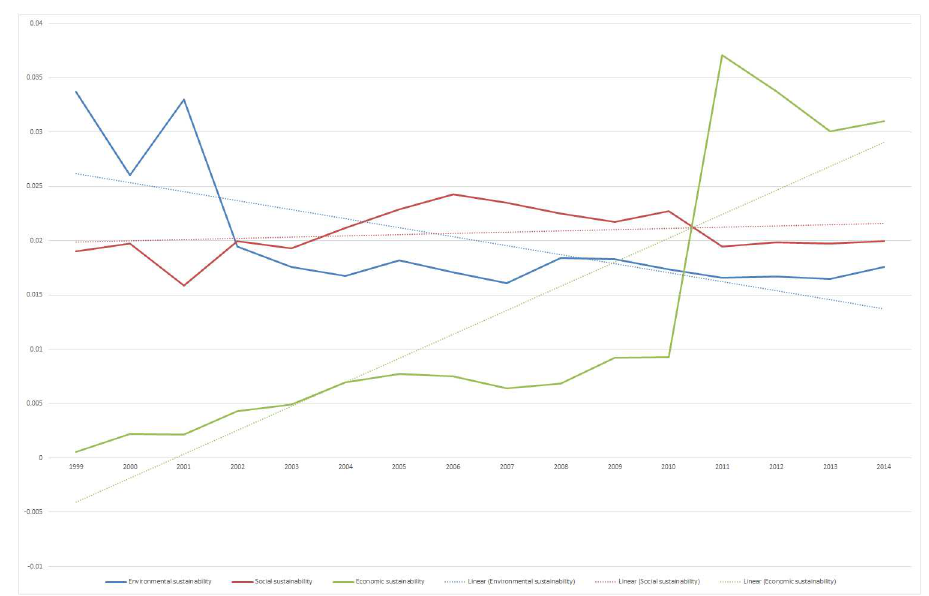
Fig 1. Trend analysis of mean probability of occurrence of environmental, social, and economic topics in the years1999 until 2014.